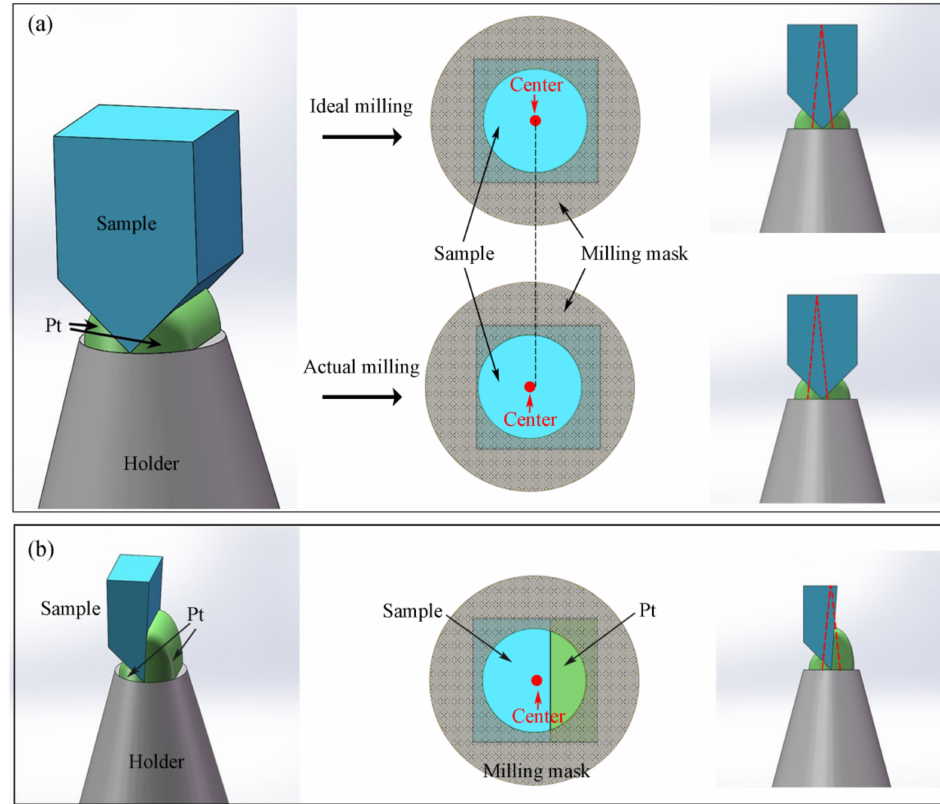
Figure 2. Welding process of standard lift-out and single-wedge lift-out. ( a ) Welding process of standard lift-out; ( b ) welding process of single-wedge lift-out.